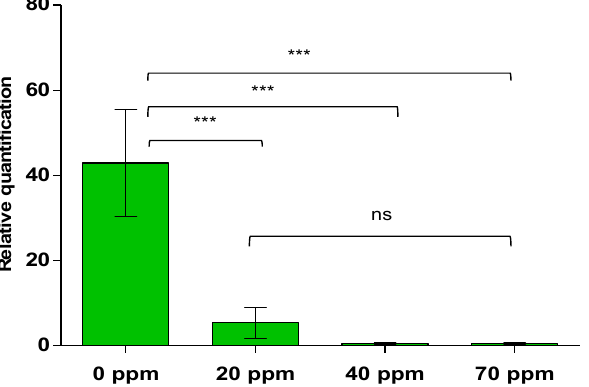
Figure 2. Tomato plants ( Solanum lycopersicum cv. Floradade) infected with the Candidatus Liberibacter solanacearum ( Ca Lso) treated with different doses of PNB. Evaluated at 25 days post-treatment.